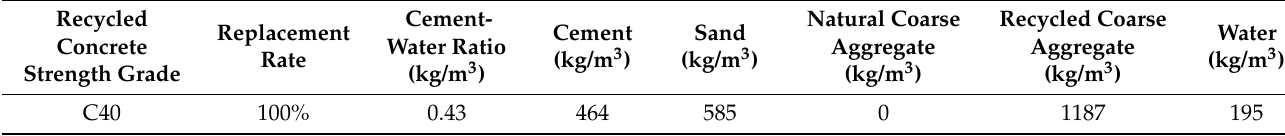
Table 2. Mix ratio of recycled concrete.